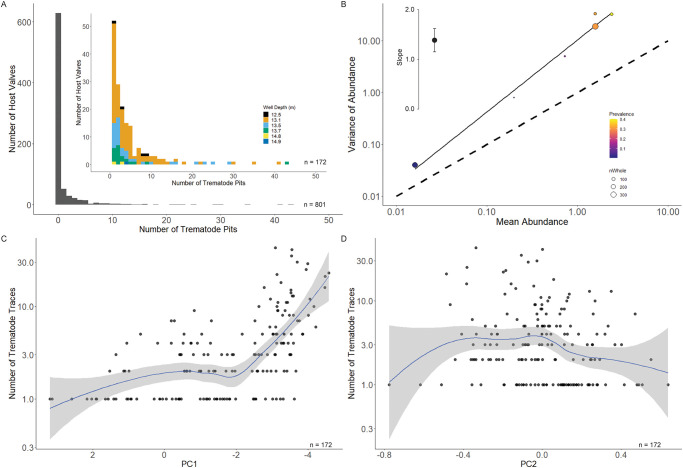
Analysis of trematode parasitism abundance.A) Frequency distribution of C. gallina valves based on the number of trematode traces per valve (abundance). Inset distribution does not include specimens without trematode pits (intensity) for clarity and is color-coded by sample. B) Sample-level analysis of mean abundance of pits and variance of the abundance of pits. Dashed line indicates the 1:1 ratio of mean: Variance. Samples on the 1:1 line would display an equal distribution of trematode pits among hosts. Values greater than a slope of one indicate aggregation of parasites. The inset figure shows the slope and 95% confidence intervals of the least square regression model. Note log10 scale of the x- and y-axes. C) PC1 (inverse proxy for body size, note reversed x-axis) and trematode abundance. Note the log10 scale of the y-axis. D) PC2 (proxy for relative pallial sinus length/relative burrowing depth) and trematode abundance. Note the log10 scale of the y-axis. The blue lines and gray fields in C and D are derived from the LOESS function and confidence intervals.